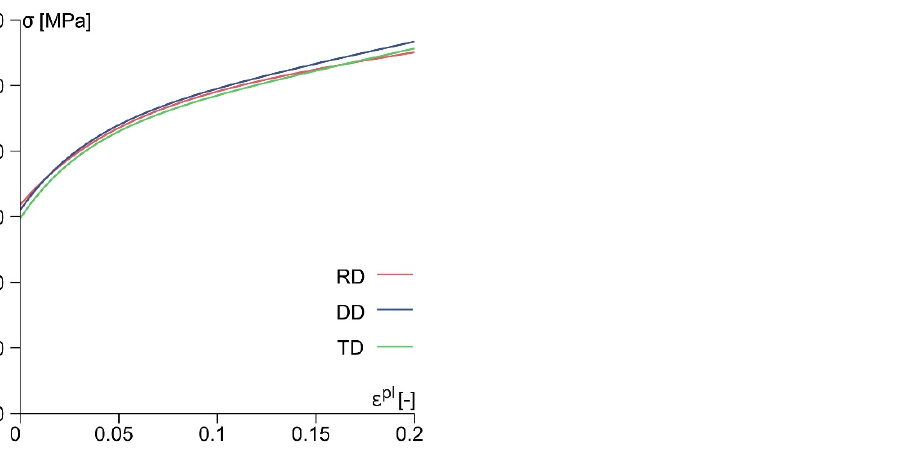
Figure 3. Experimental true stress–true plastic strain curves, tension experiment, EN AW-2017A aluminum alloy.